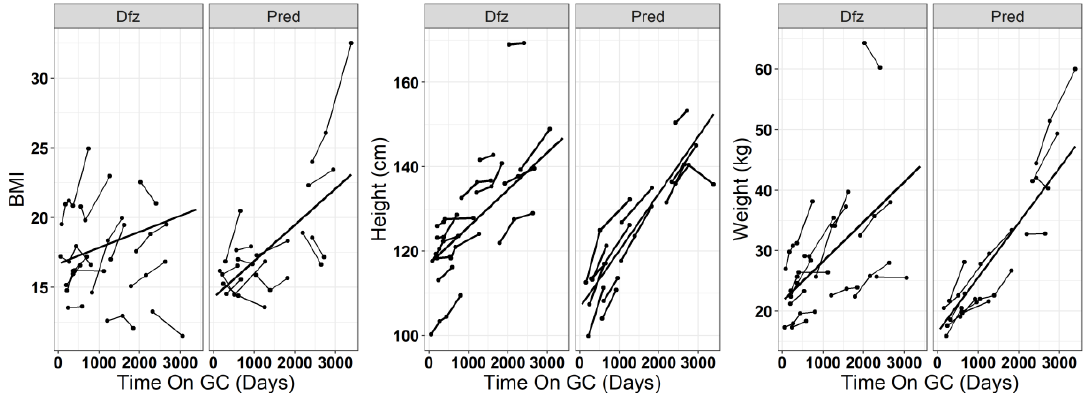
Figure 4. Comparison of longitudinal trajectories between DMD patients treated with deflazacort and prednisone of BMI ( p = 0.08 for difference in trajectory slopes), height (cm; p = 0.006), and weight (kg; p = 0.112).